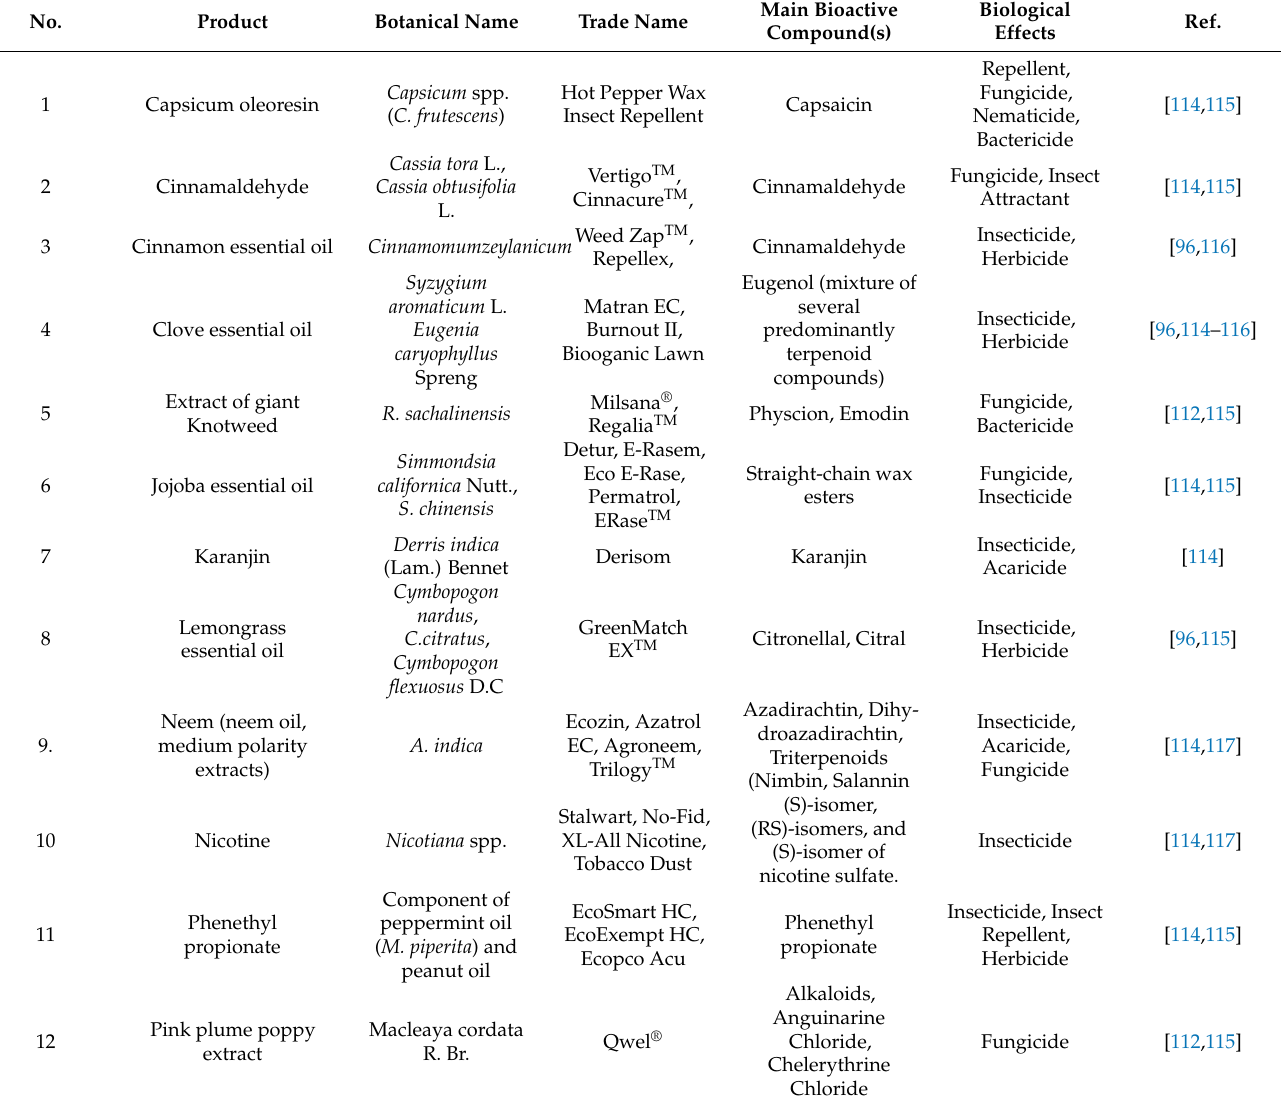
Table 2. Some commercial botanical pesticides, bioactive compounds, and biological